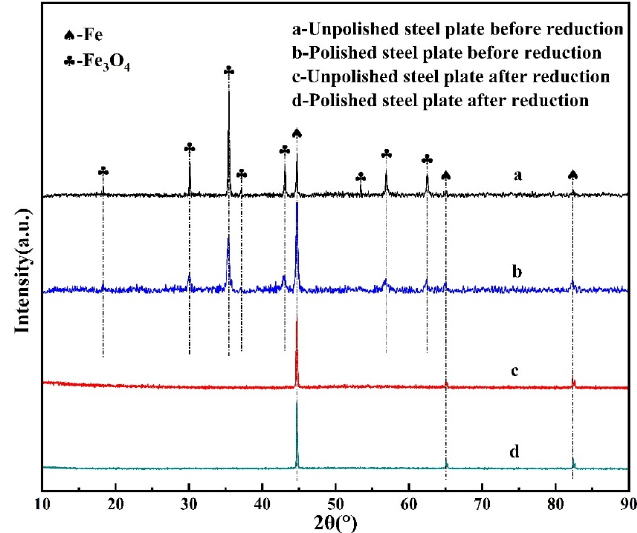
Figure 4. XRD patterns of the surface of unpolished and polished steel plate. Table 3. Depth of X-ray detection of Fe and its oxides (μm).